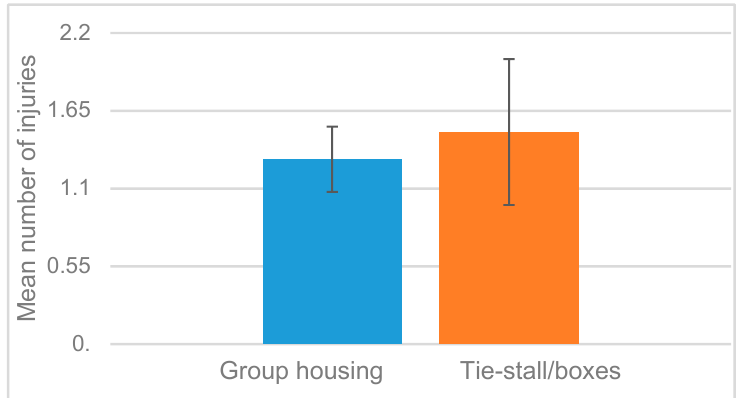
Figure 1. Average number of abnormal health condition findings per horse and riding school (bars indicate standard error of the mean).